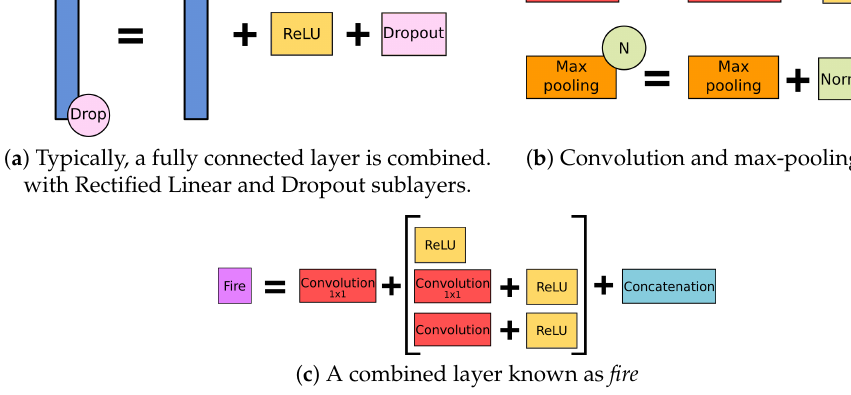
Figure 6. The layers used in the examined networks.